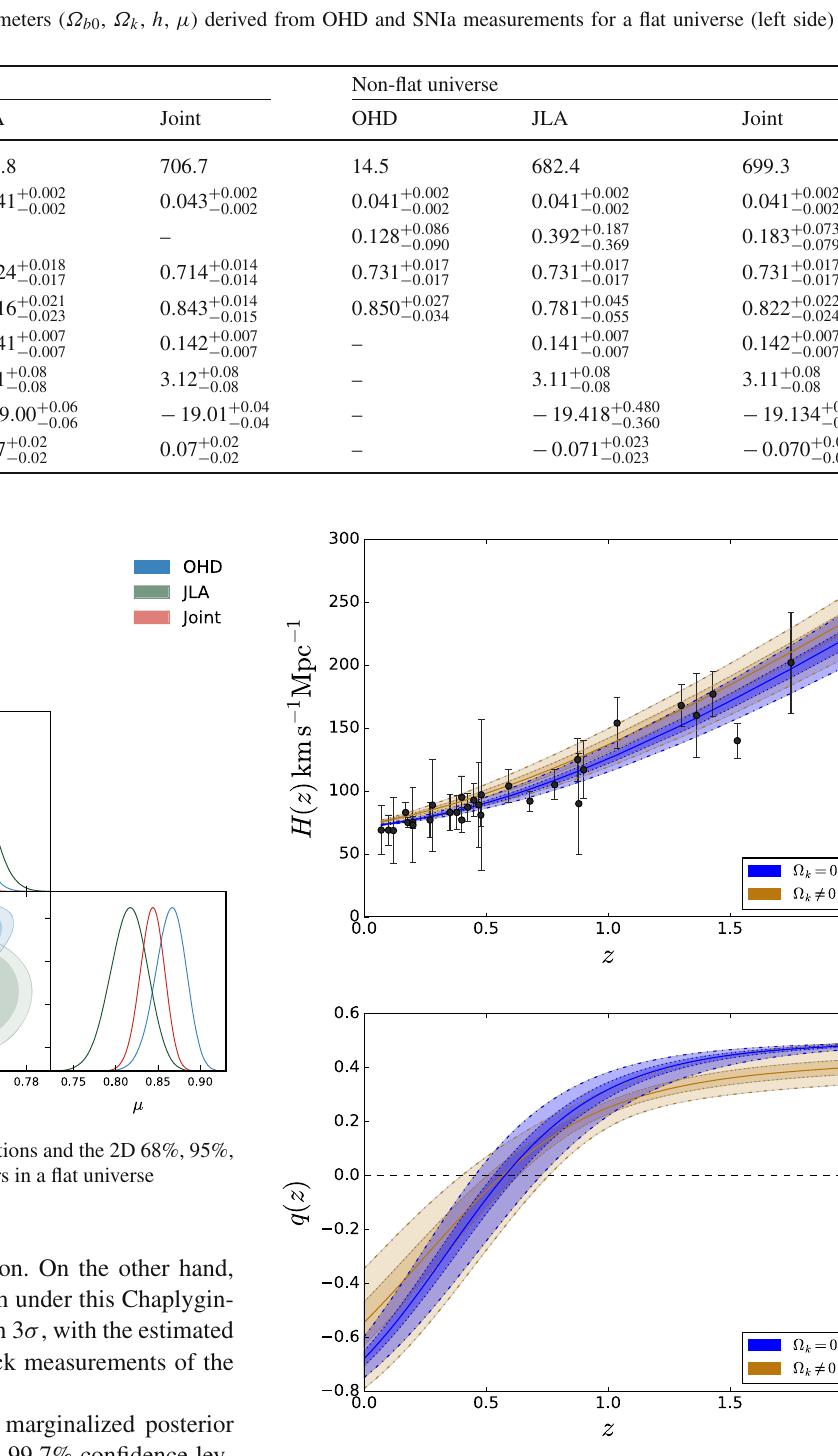
Fig. 2 Best fit to cosmic chronometers OHD (top panel) and recon- struction of the deceleration parameter (bottom panel) using the con- straints from the joint analysis for both, flat (blue color) and non-flat (brown color) models. The uncertainty bands refers to 68% (inner band) and 99 . 7% (outermost band)